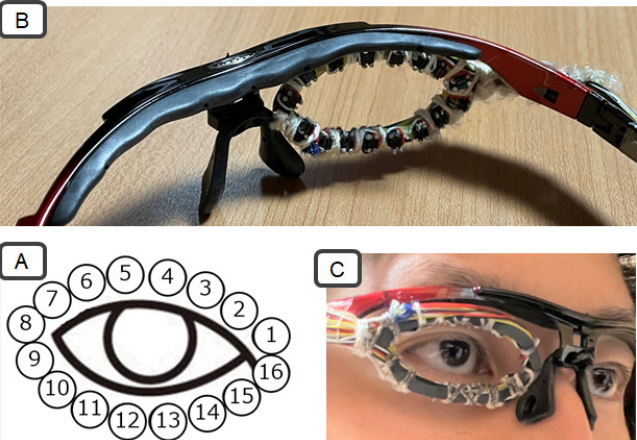
Figure 3. ( A ) Sensor positions, ( B ) sensor device, and ( C ) wearing the sensor device. Reprinted with permission from Ref. [25]. Copyright 2021